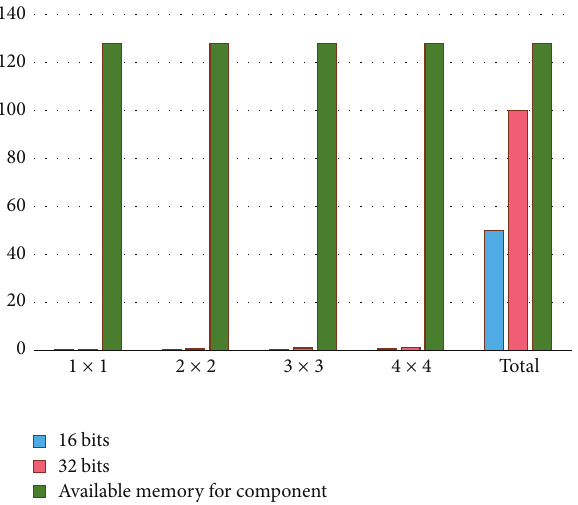
Figure 15: Storage requirements (matrix size 5000 × 5000 ).